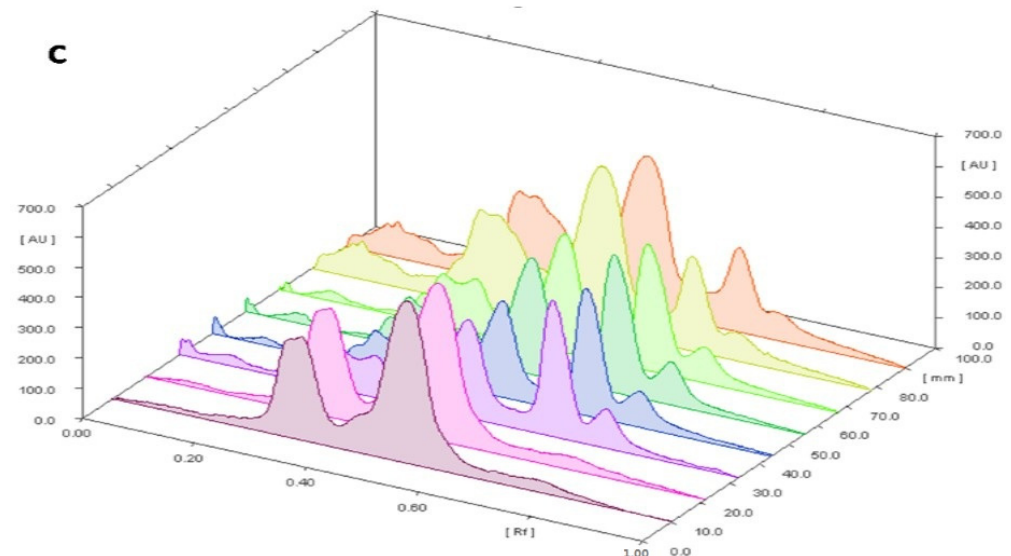
Figure 3. ( A ) 3D Chromatogram of 8 tracks of T. ammi L. oil obtained by different extraction techniques at A: 254 nm; ( B ) 3D Chromatogram of 8 tracks of T. ammi L. oil obtained by different extraction techniques at B: 366 nm; ( C ) 3D Chromatogram of 8 tracks of T. ammi L. oil obtained by different extraction techniques at B: 580 nm.